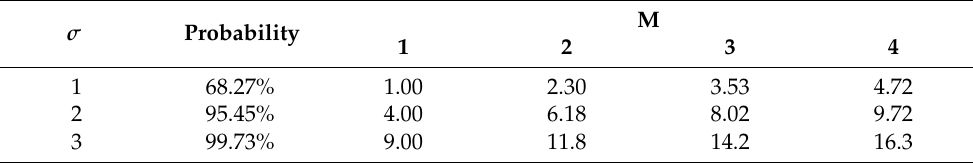
Figure 12. Confidence regions derived using a constant ∆ χ 2 region as a boundary. Here, the shape of the confidence region is chosen to be an ellipse. It is important to note that the intervals AA’, BB’, CC’ are the ones that contain the percentage of the normally distributed data that correspond to the respective ∆ χ 2 . Adapted from: [41]. Table 1. Table containing ∆ χ 2 values as a function of confidence level p and the number of parameters M. The process used to derive these values can be seen in Appendix